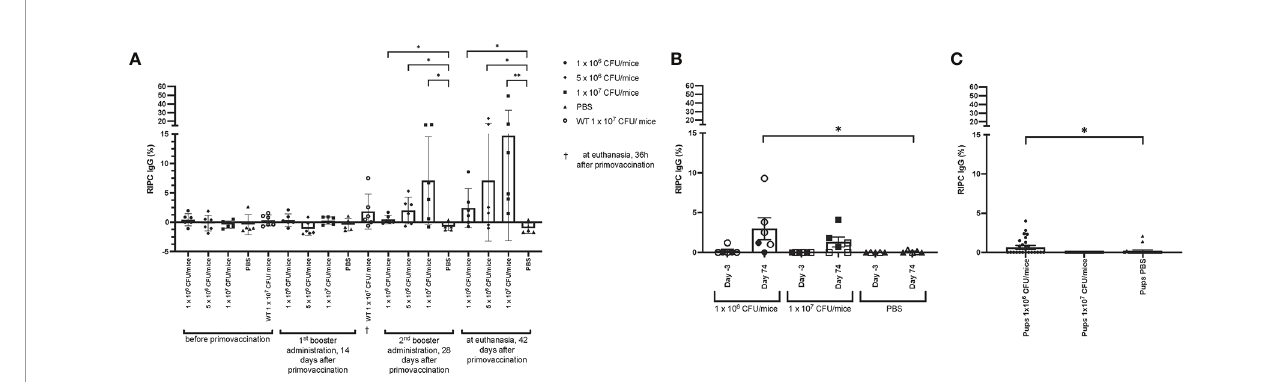
FIGURE 9 | Antibody titers in Lm3Dx_SAG1-immunized mice. (A) NcSAG1 IgG in Lm3Dx_SAG1-immunized non-pregnant mice (experiment 1; 1 x 10 6 , 5 x 10 6 or 1 x 10 7 CFU/mice dose groups). Naïve mice (PBS) were included as negative control for each time point of measurement. (B) NcSAG1 IgG response in Lm3Dx_SAG1-immunized mice in the pregnancy outcome model (experiment 3; 1 x 10 6 and 1 x 10 7 CFU/mice dose groups, empty triangle, square or circle = non- pregnant mice, fi lled triangle, square or circle = pregnant mice). Naïve mice (PBS) were included as negative control for each time point of measurement. Sera were taken 3 days prior to primary vaccination (Day -3) and 42 days after the 2nd booster administration (74 days following primary vaccination, Day 74). (C) NcSAG1 IgG response in pups born from Lm3Dx_SAG1-immunized dams in the pregnancy outcome model (experiment 3; 1 x 10 6 and 1 x 10 7 CFU/mice dose groups). Sera were taken three weeks after birth during euthanasia and compared to sera from pups born from PBS vaccinated dams. Results are expressed as the mean of RIPC (relative index per cent) in relation to the positive control (serum of Nc infected mice), and error bars represent the standard error of the means (S.E.M) in each group. *P ≤ 0.0332, **P ≤ 0.0021 (Mann Whitney-U